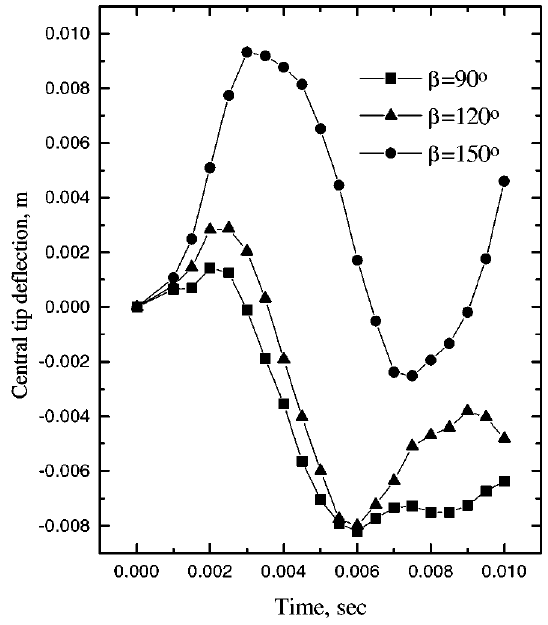
Fig. 9. Comparative study of central tip deflection for E-glass–Epoxy 2 fold laminated cantilever folded plates, with 30 (cid:14) = (cid:0) 30 (cid:14) lamina- tion, 6 (cid:2) 3